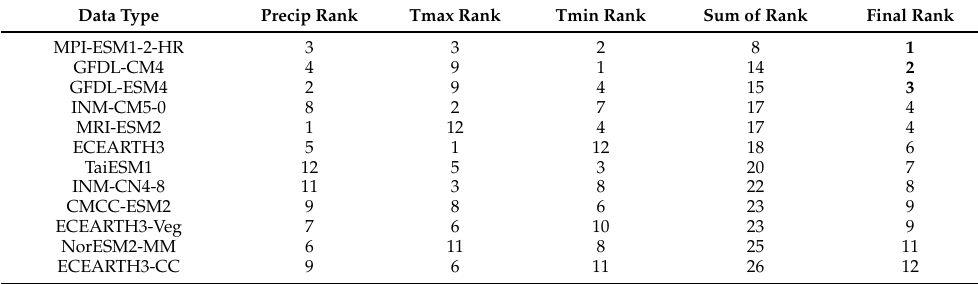
Table 7. Summary results for all three climatic